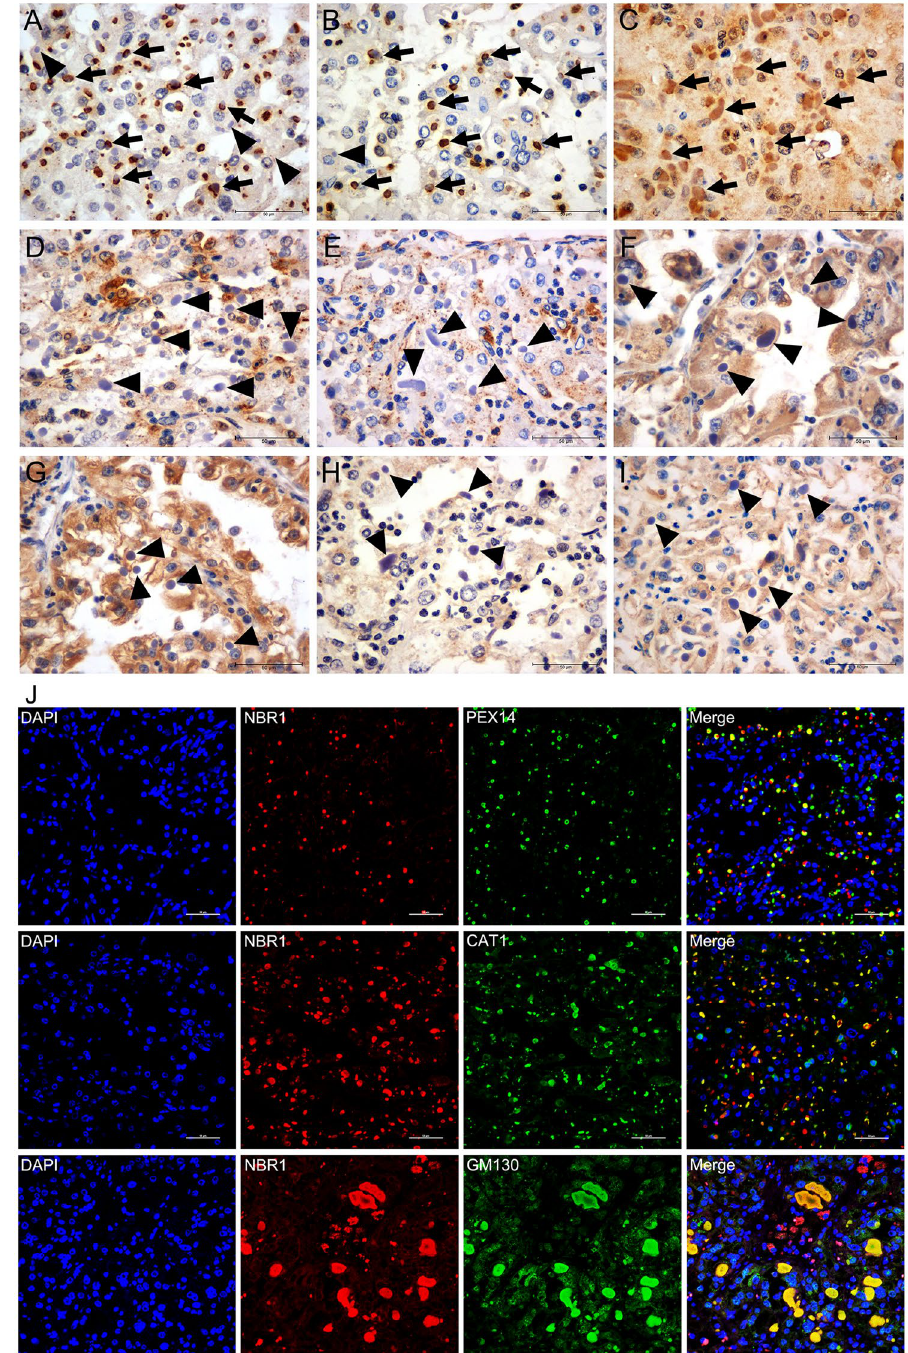
Figure 4. Localization of organelle markers in ECIs of RCCs. Immunohistochemical staining showed that ECIs were intensively positive for PEX14 and CAT1 (two markers of peroxisomes, arrows in A and B ). Some of the ECIs were positive for GM130 (a marker of Golgi apparatus, arrows in C ). None of the ECIs exhibited immunoreactivity of LAMP1 and LAMP2 (two markers of lysosome or autolysosome, arrowheads in D and E ), TOM20 (a marker of mitochondria, arrowheads in F ), CALR (a marker of the endoplasmic reticulum, arrowheads in G ), RPS6 (a marker of ribosomes, arrowheads in H ), or RAB5A (a marker of early endosomes, arrowheads in I ). Double- immunofluorescence labelling of ECIs revealed that most of the NBR1-positive ECIs were positive for PEX14 and CAT1, and that a portion of them displayed moderate GM130 staining ( J